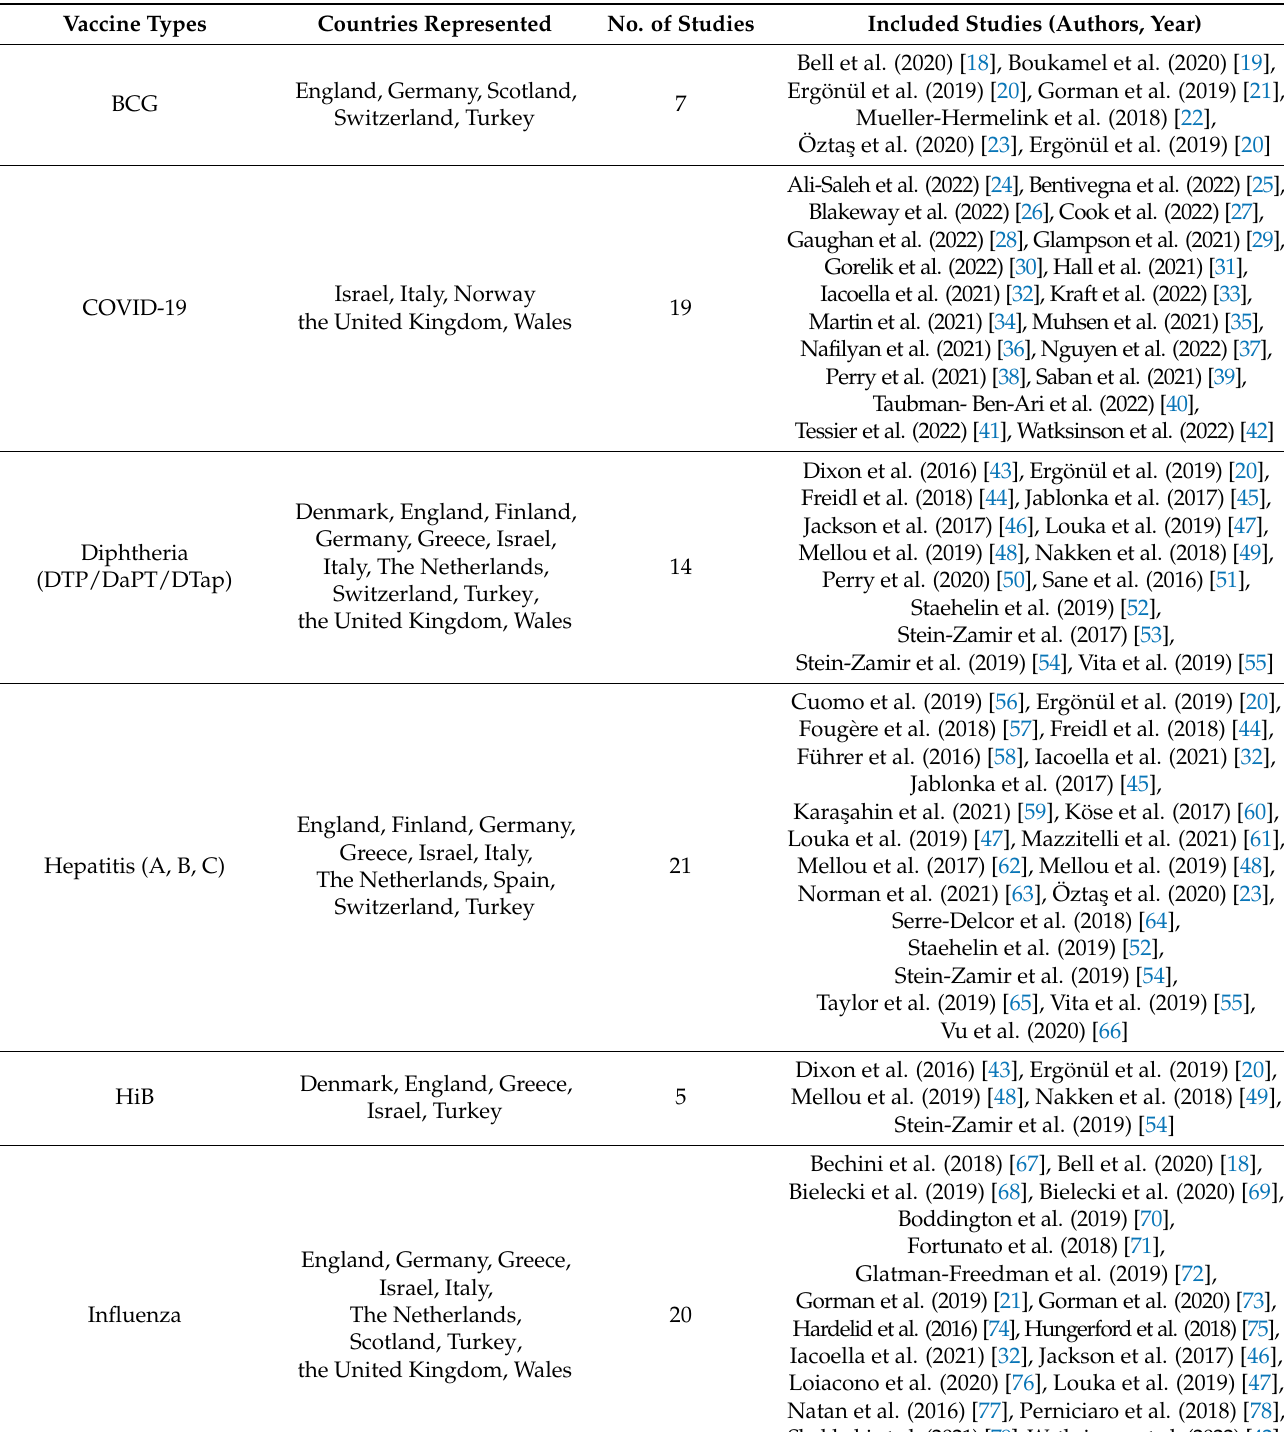
Table 1. Summary of vaccines identified in the included